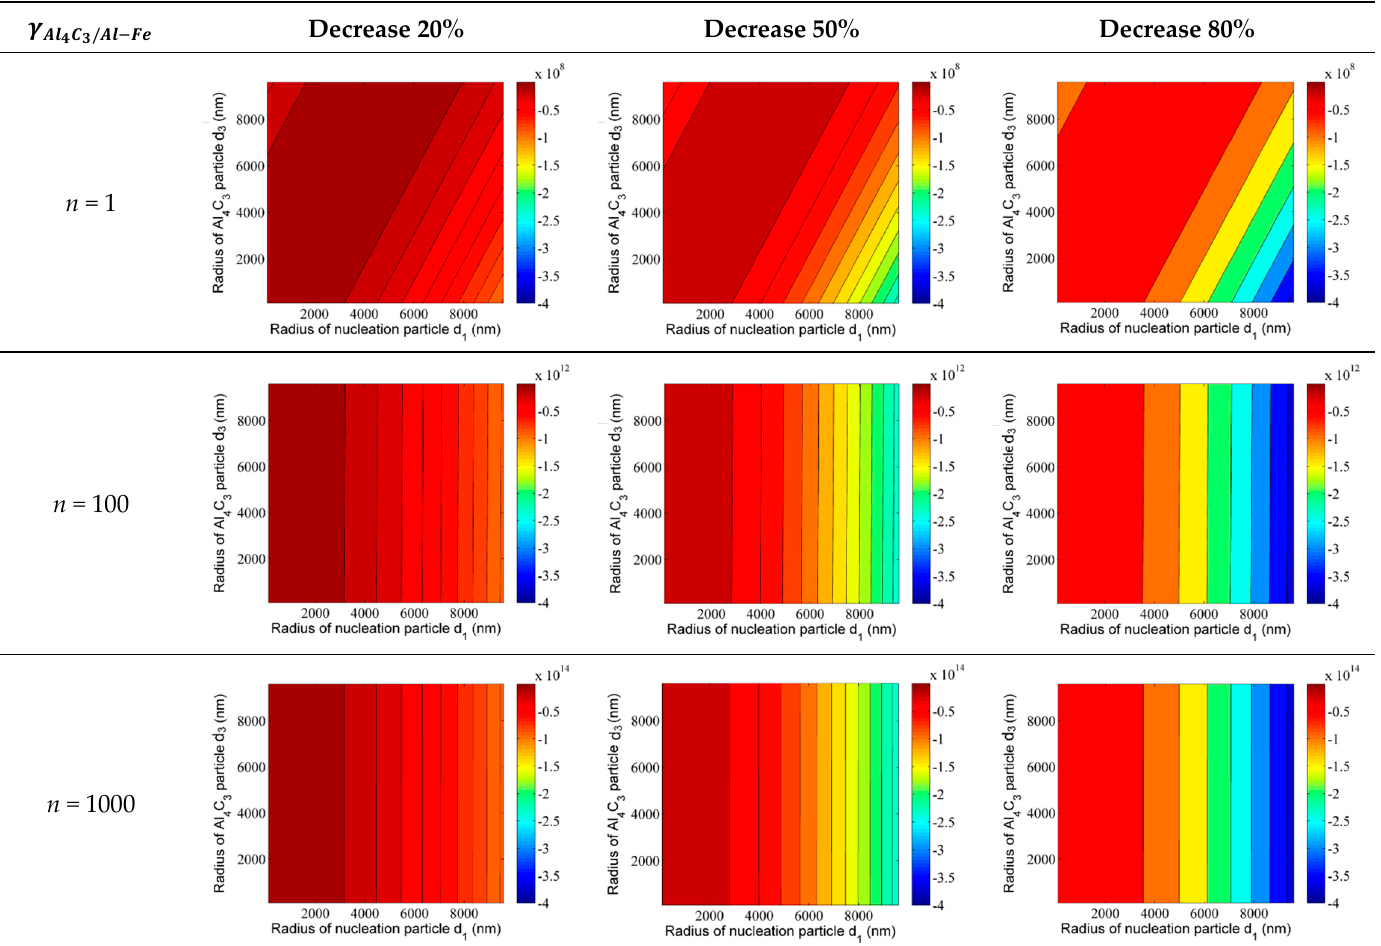
Figure 12. The change of Gibbs free energy after Ca addition. The number of adsorption layers is 10, 100, and 1000, respectively.